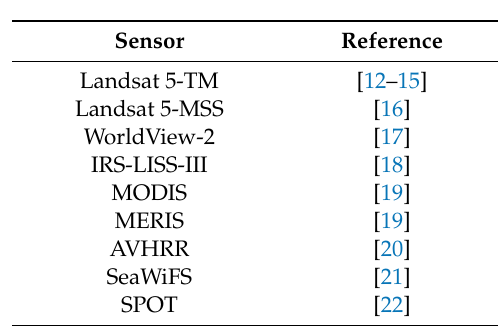
Table 1. Literature review of the estimation of physicochemical parameters of water using a remote